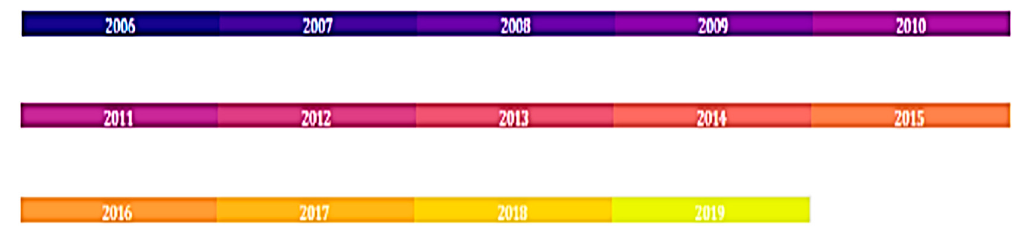
Figure A6. Year–colour correspondence bar.